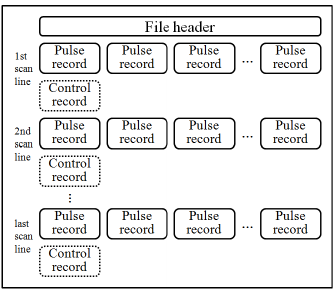
Figure 1. Generalised structure of SDF file format